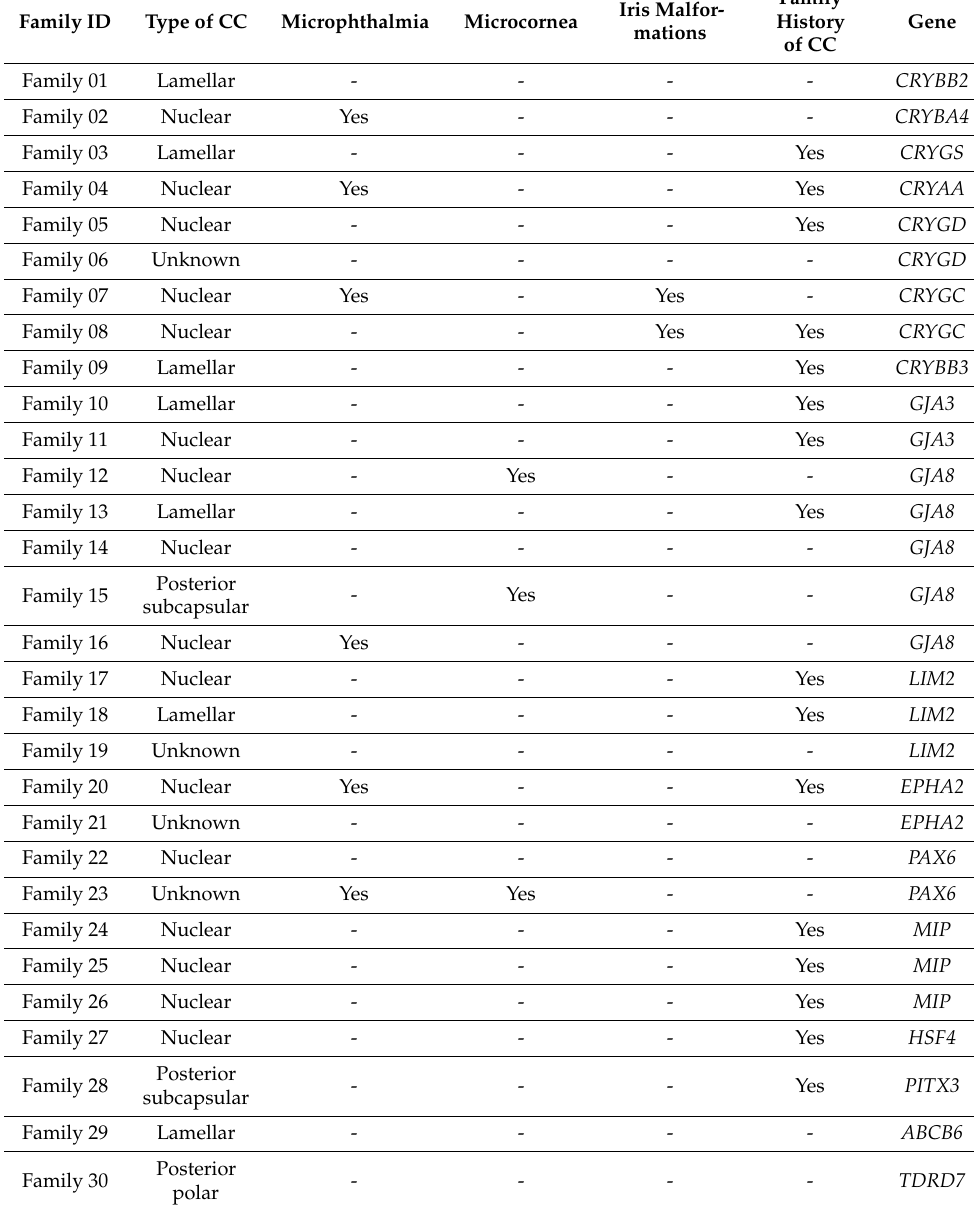
Table 1. Congenital cataracts phenotype